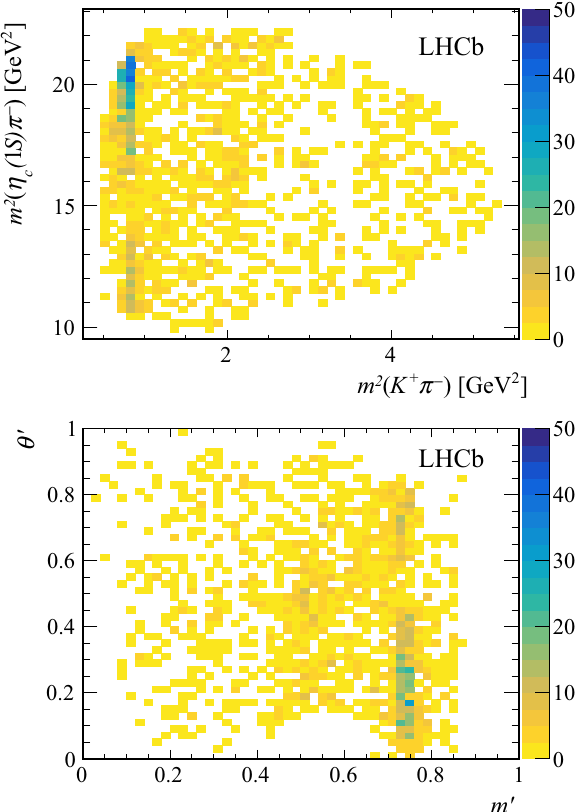
Fig. 6 Background-subtracted (top) DP and (bottom) SDP distribu- tions corresponding to the total data sample used in the analysis. The structure corresponding to the K ∗ ( 892 ) 0 resonance is evident. The veto of B 0 → η c K + π − decays in the D 0 region is visible in the DP